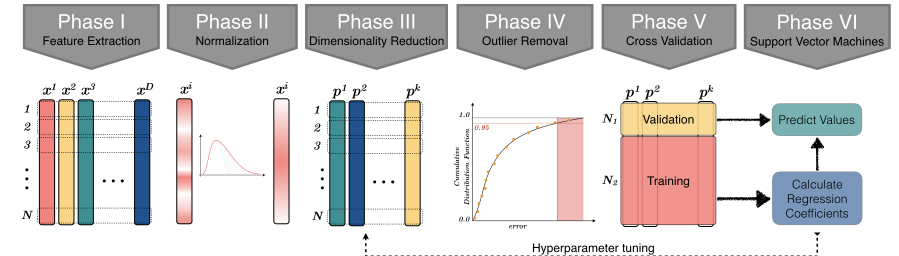
Fig 3. Modular machine learning workflow for predictive modeling of macro-socioeconomic indicators.